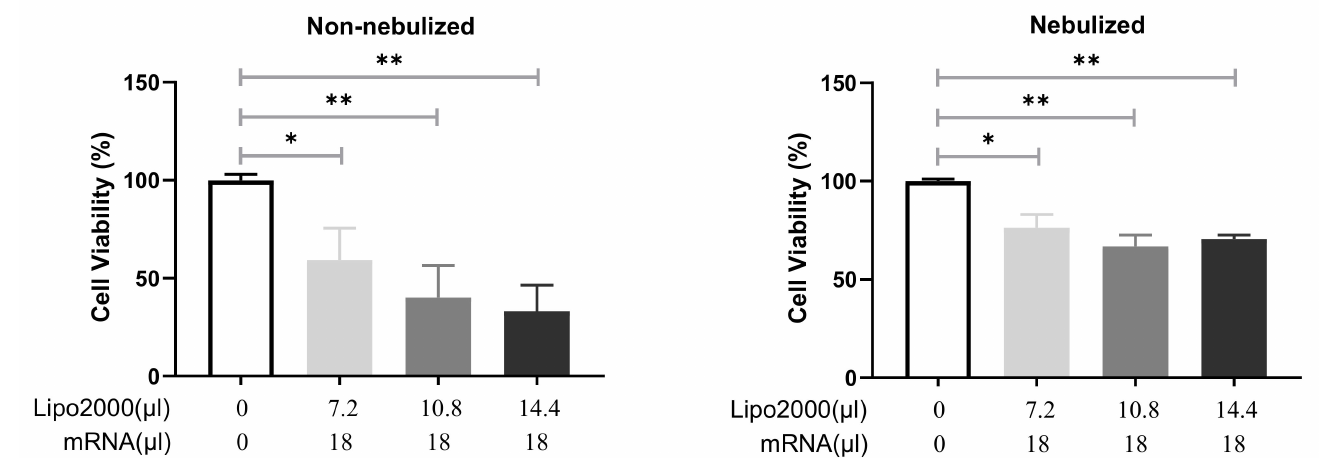
Figure 7. Cytotoxicity profile of MetLuc-mRNA/Lipofectamine2000 complexes prepared by Protocol 2 towards 16HBE cells. The complexes were prepared in OptiMEM and incubated with 16HBE cells for 2 h. Totals of 7.2 µ L, 10.8 µ L and 14.4 µ L Lipofectamine2000 were mixed with 18 µ L MetLuc-mRNA. “Lipo2000” represents Lipofectamine2000 and “mRNA” represents MetLuc-mRNA. A fraction of the complexes was kept separately and used as a “non-nebulized” sample. The rest of the solution was aerosolized for 5 min using a PARI Boy ® jet-nebulizer and the collected part was used as a “nebulized” formulation. Cell viability was assayed 24 h after transfection. Untreated cells were used as 100%, n = 6. The results were analyzed for the statistical significance with a two-tailed unpaired Student’s t -test: * p < 0.05 and ** p <